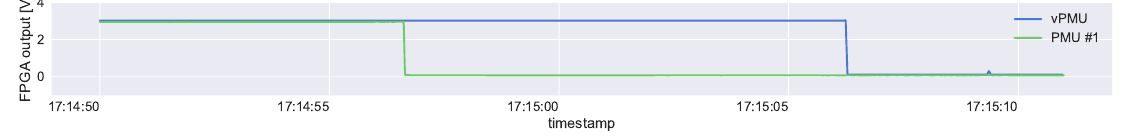
Figure 3. Non-synchronized step response of virtual and real PMUs.